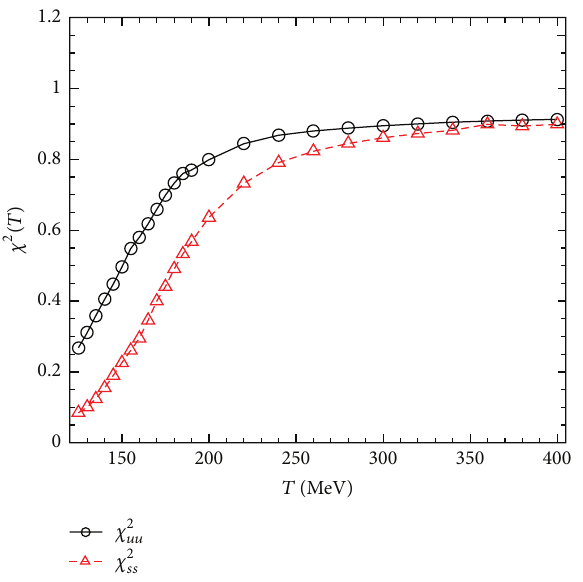
Figure 1: The continuum limit of light and strange quark suscepti- bilities from [14] (color online).